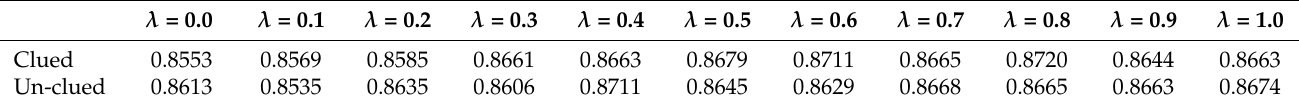
Table 1. Validation accuracy by λ (length = 128